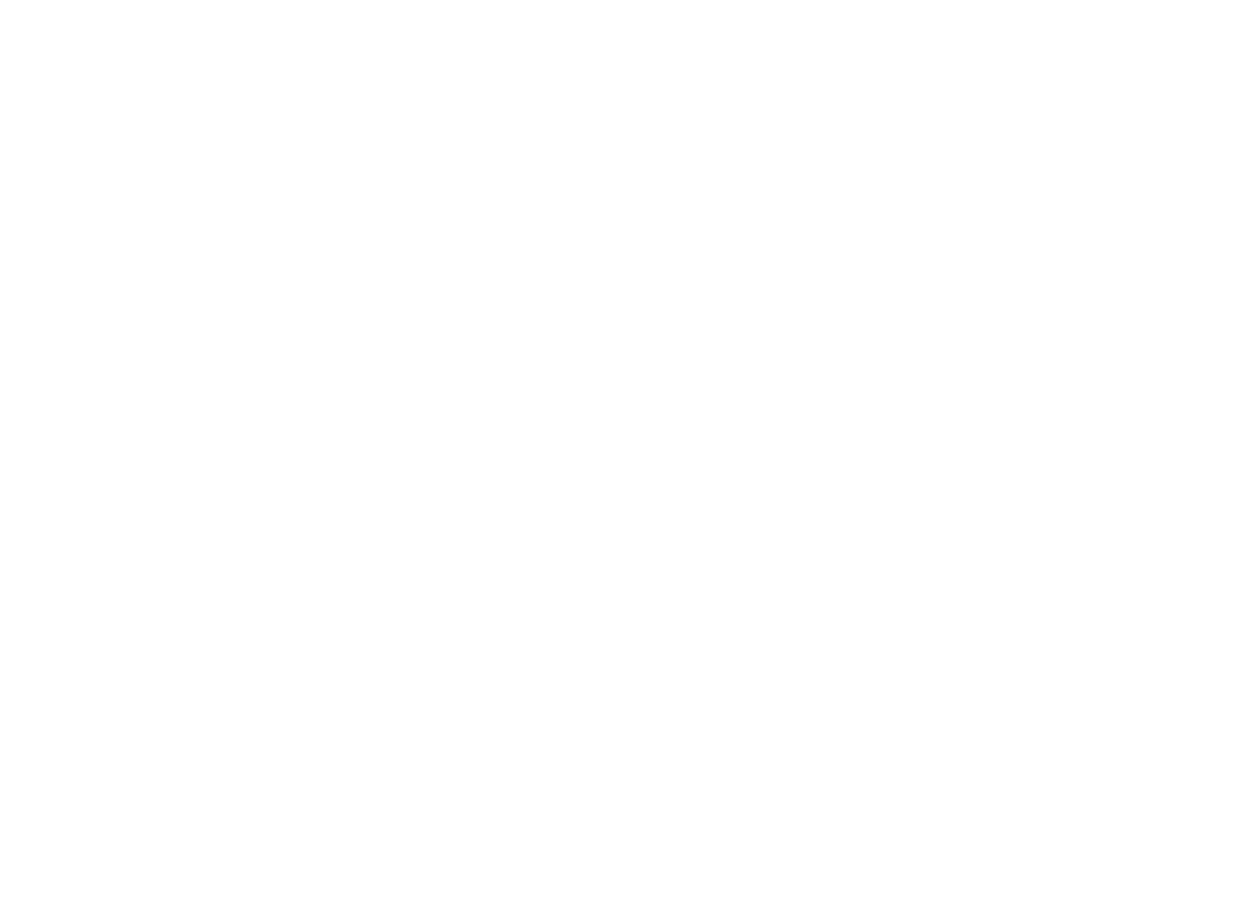
Frontiers in Built Environment |